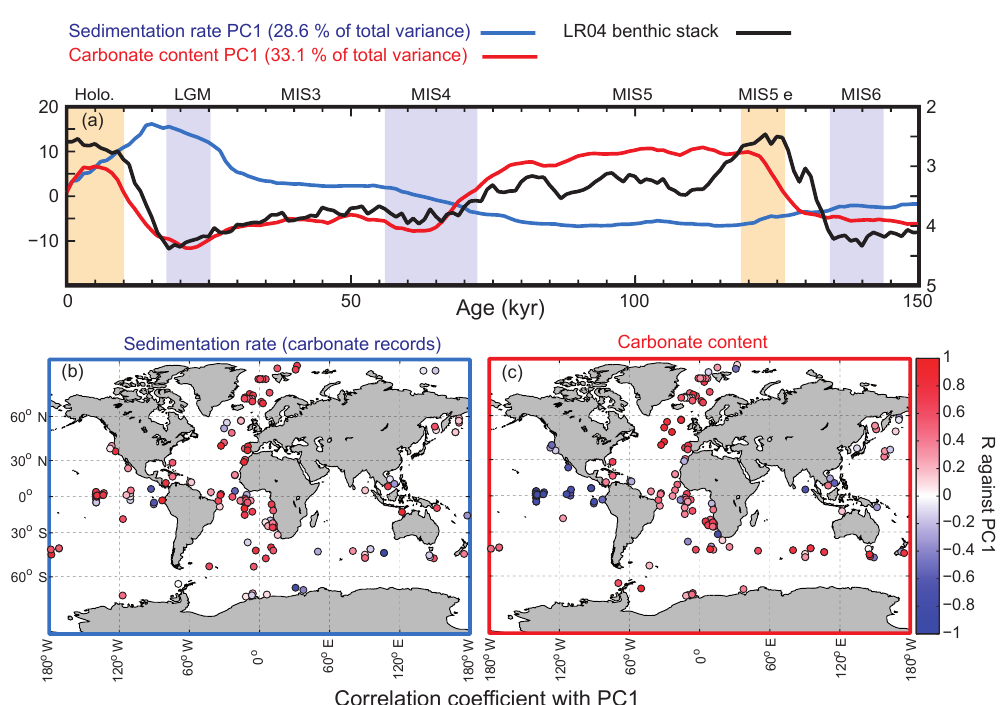
Figure 6. Principal components of temporal variation in sediment mass accumulation rates and CaCO 3 concentrations. The first principal component (PC1) is displayed in panel (a) for both sedimentation rates and carbonate content, and explains 28.6% and 33.1% of the total variance, respectively. Yellow vertical bars correspond to Holocene and MIS5e; blue vertical bars are for LGM, MIS4, and MIS6. Panels (b) and (c) show the correlation coefficients for individual records of sedimentation rates and carbonate content, against their respective PC1. In this analysis, we used only records that cover 80% of the studied